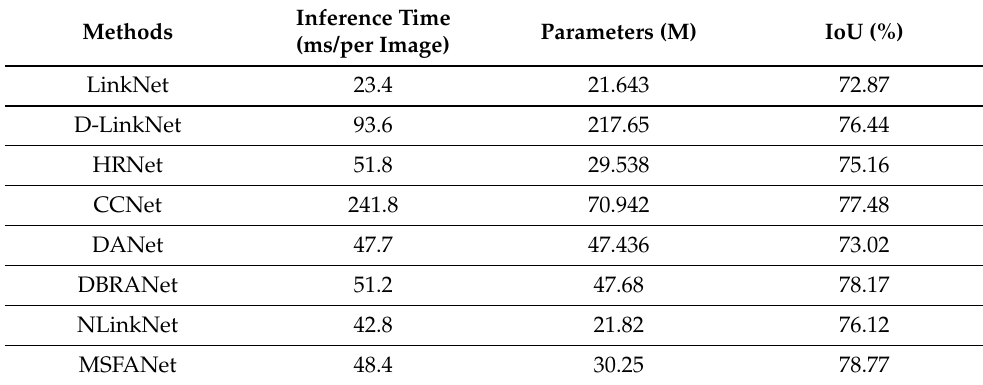
Table 5. Inference time, number of network parameters and IoU metrics of different